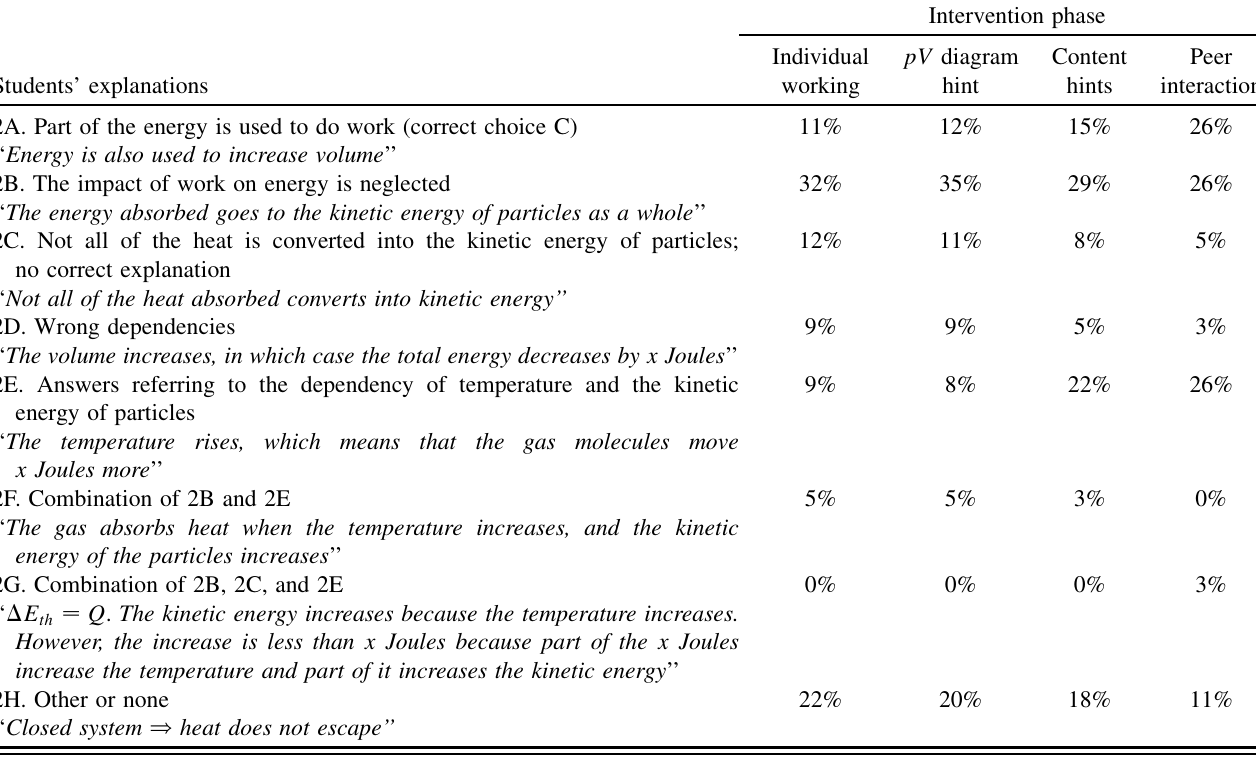
TABLE VIII. Students’ categorized explanations regarding change in the kinetic energy of particles in an isobaric expansion process. N ¼ 65 . A typical example from each category is presented after the category symbol in